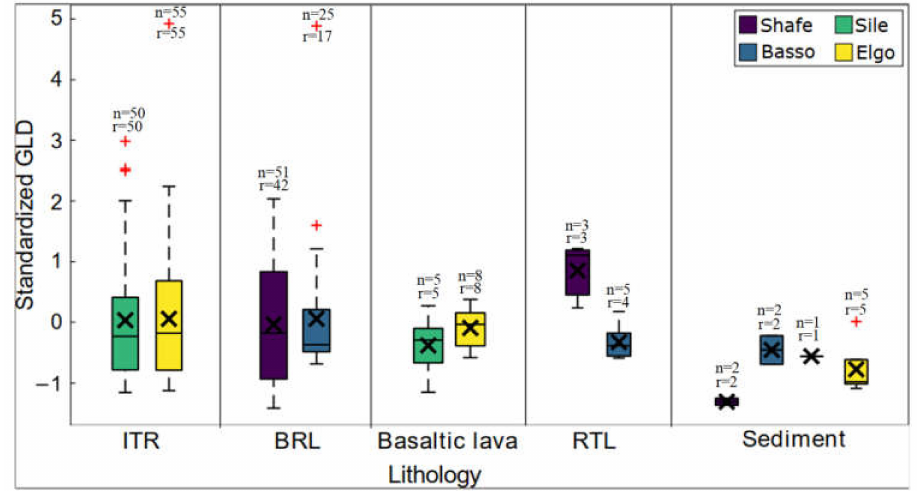
Figure 8. Relationships between lithology and standardized GLD per river catchment. Boxplots give lower and upper quartiles and median. The mean GLD represented by X. Outliers beyond whiskers are shown as +. n represents the number of sub-catchments for each type of lithology and r represents the number of sub-catchments for each lithology type in rejuvenated